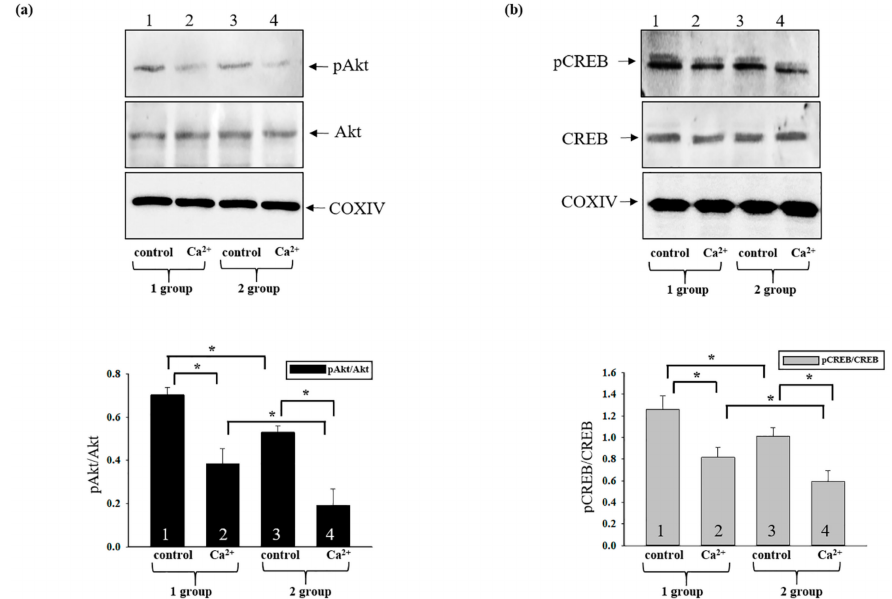
Figure 7. The e ff ects of AST administration on pAkt and pCREB levels during mPTP opening. ( a , b ) Upper parts: Western blots stained with corresponding antibodies; lower parts: ratios of pCREB to total CREB, and pAkt to total Akt. COX IV was used as a loading control. Data are presented as means ± SDs of five independent experiments. * p < 0.05—significant di ff erence in protein level compared with corresponding